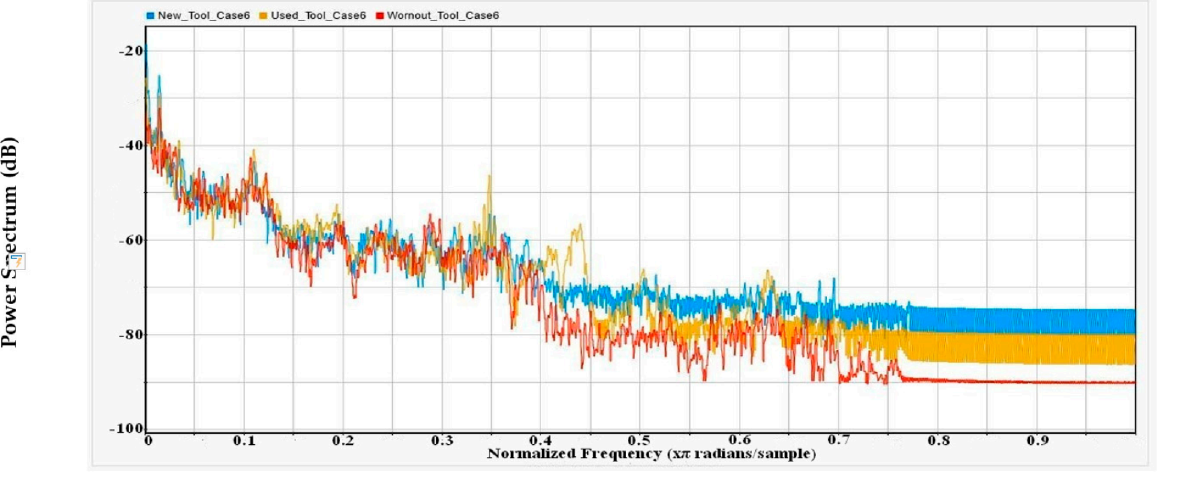
Figure 21. Power spectral density (PSD) for Case-6 of new (blue), used (yellow), and worn-out (red) tool with maximum leakage